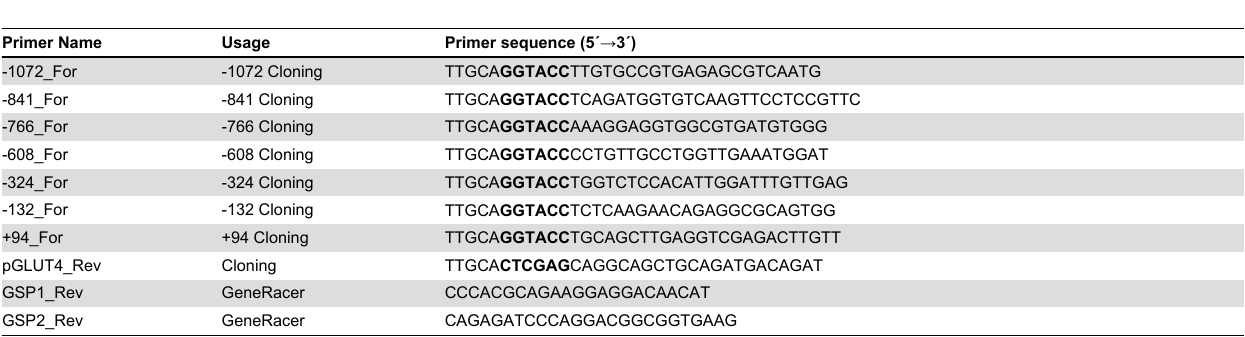
Table 1. Primer sequences used in the cloning of the deletion constructs and in the identification of the transcription start